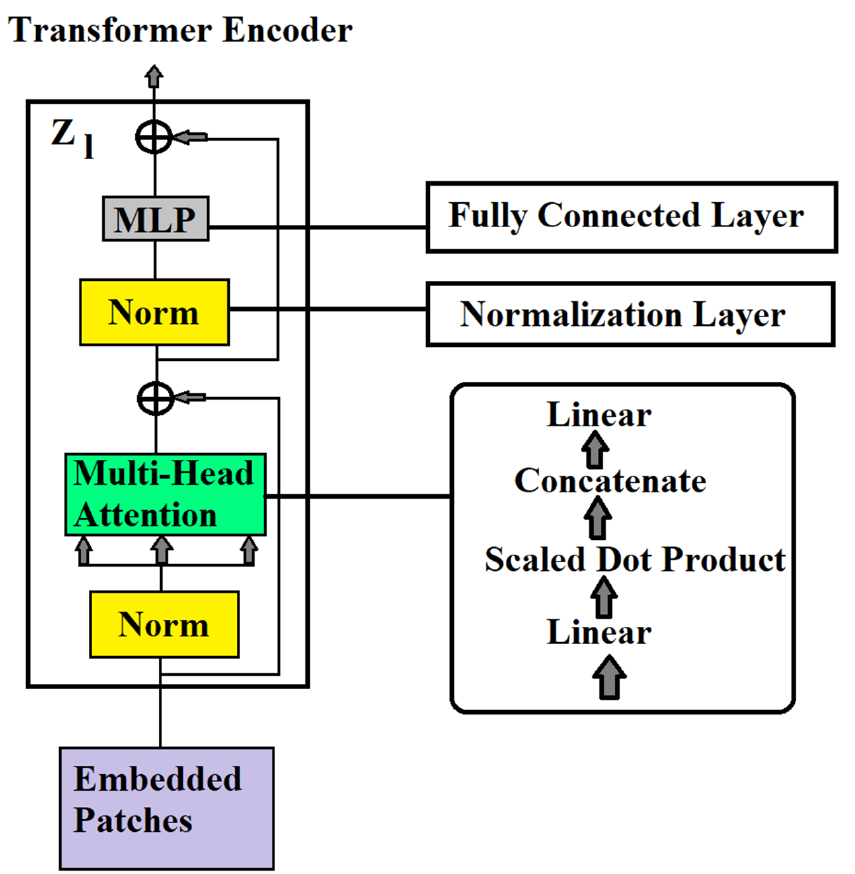
Figure 7. Transformer block for the Vision Transformer classification model.